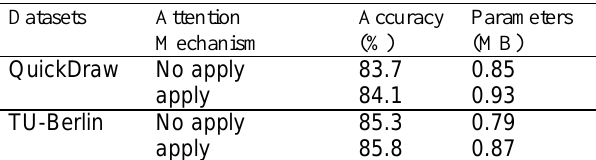
Table 5. Effect of Attention Mechanism Datasets